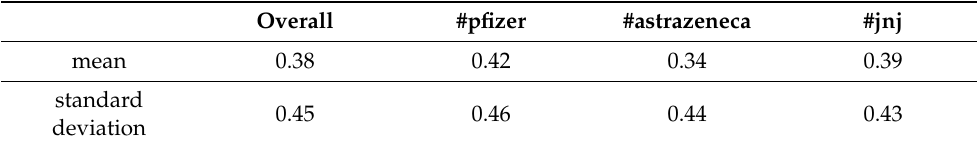
Table 6. Mean and standard deviation polarity values.